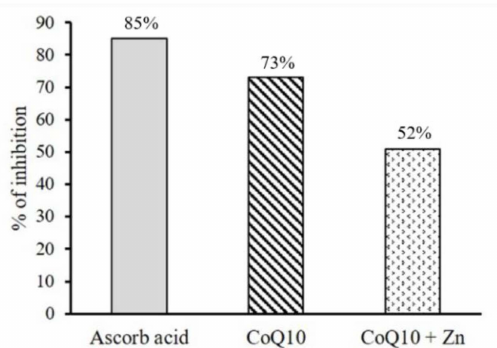
Figure 4. Percentage of inhibition of DPPH radical in 5 s by the antioxidant activity of CoQ10 (0.5 mg/mL) and CoQ10 + Zn (0.5 + 0.05 mg/mL, respectively) compared to the ascorbic acid standard (1